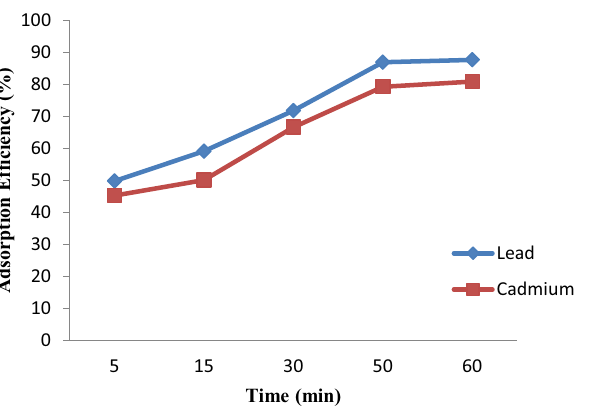
Fig. 4 Effect of Temperature on Pb 2+ and Cd 2+ Adsorption by